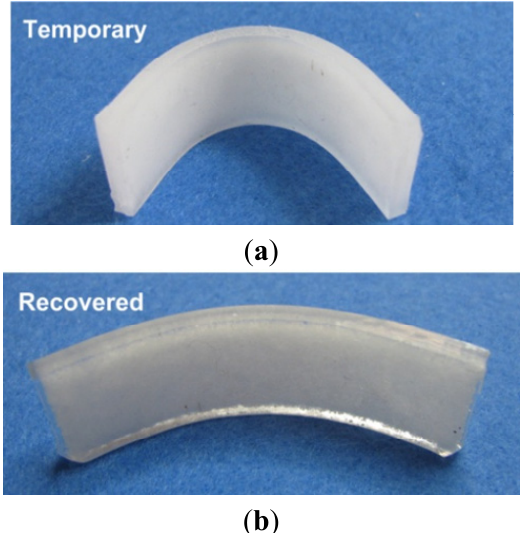
Figure 21. Silicone–water hybrid with a sharp transition temperature of ±0 °C. ( a ) After programming; and ( b ) after recovery. (Reproduced with permission from [5]. Copyright 2012 Elsevier).